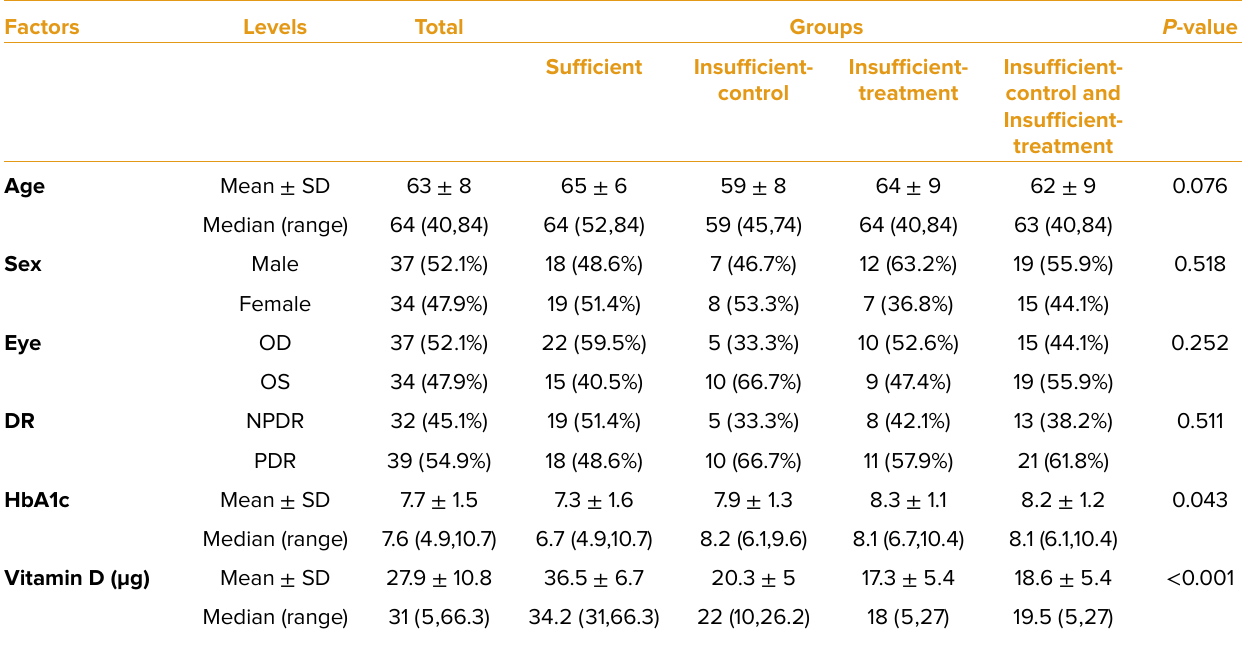
Table 1. Demographic and clinical features Factors Levels Total Groups P -value